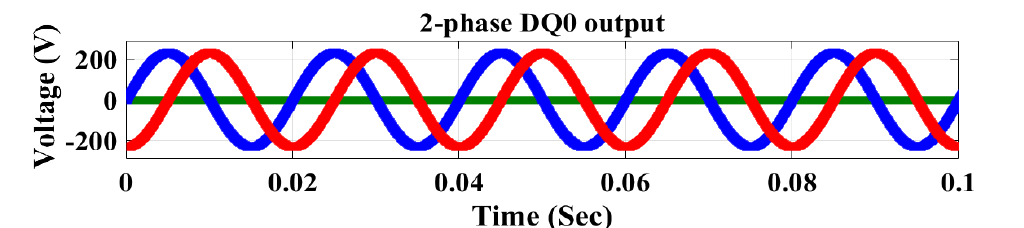
Figure 10. Two phase DQ0 output voltage of SSTPI